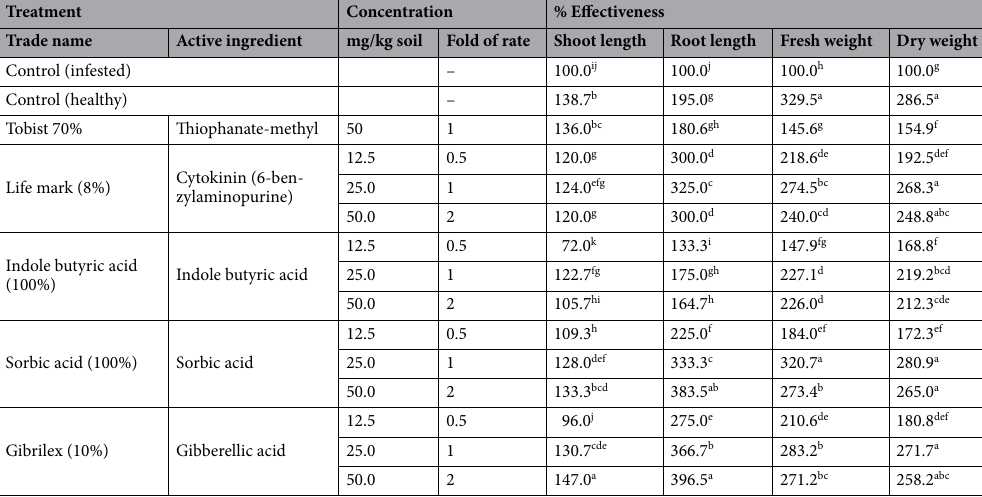
Table 3. Effect of chemical resistance inducers on growth parameters of tomato plants grown in Fusarium infested soil under greenhouse condition. Means in the column followed by different letters indicate significant differences among treatments at P ≤